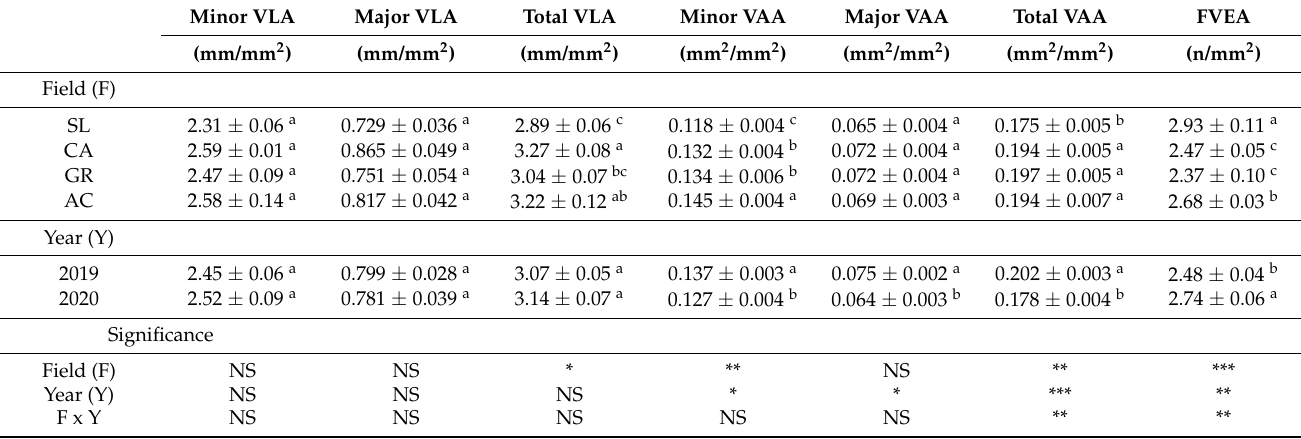
Table 4. Effects of field (F), year (Y), and their interaction (F x Y) on vein traits in leaves of V. vinifera ‘Falanghina’ vines at the four study sites: SL -Santa Lucia, CA-Calvese, GR-Grottole, AC-Ac- quafredde. Mean values and standard errors are shown.